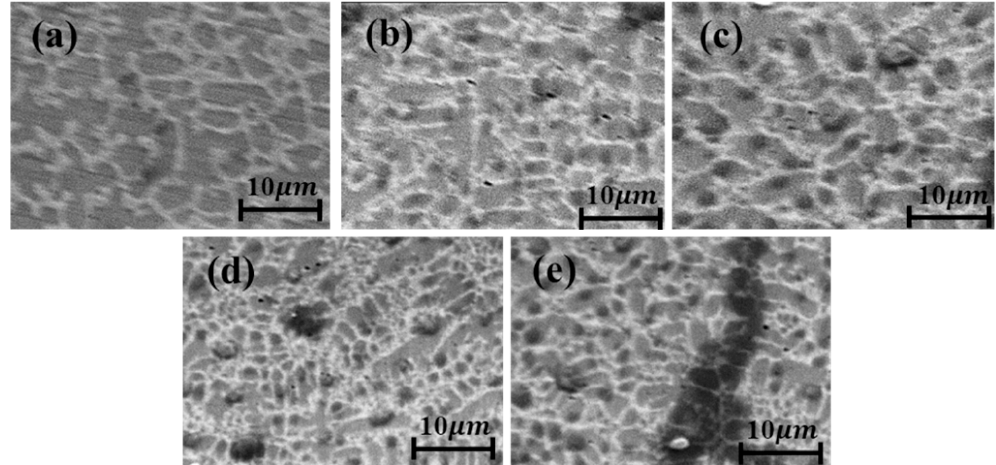
Figure 9. SEM of ( a ) Sn 0 , ( b ) Sn 0.1 , ( c ) Sn 0.2 , ( d ) Sn 0.3 , ( e ) Sn 0.5 alloy coatings.